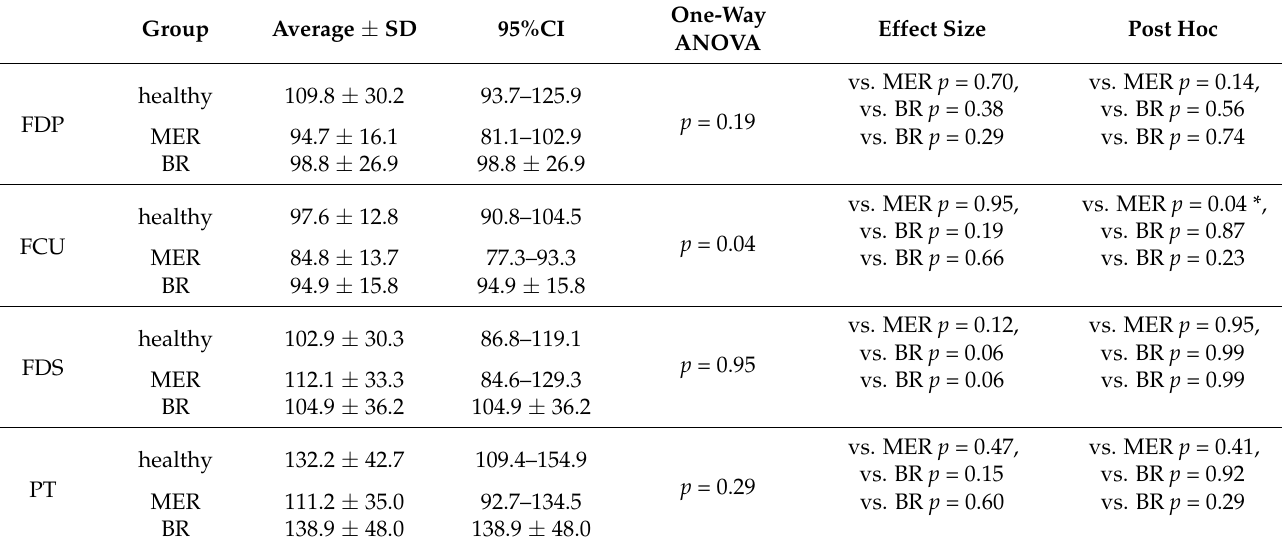
Table 5. Comparison of contraction CSA between the three